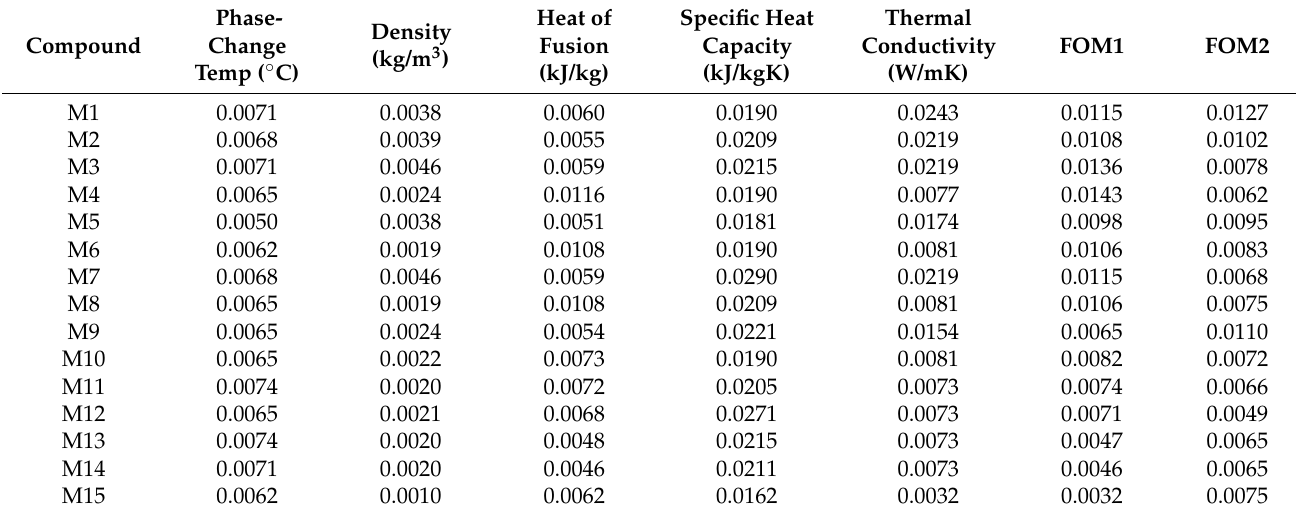
Table 17. COPRAS weighted matrix.